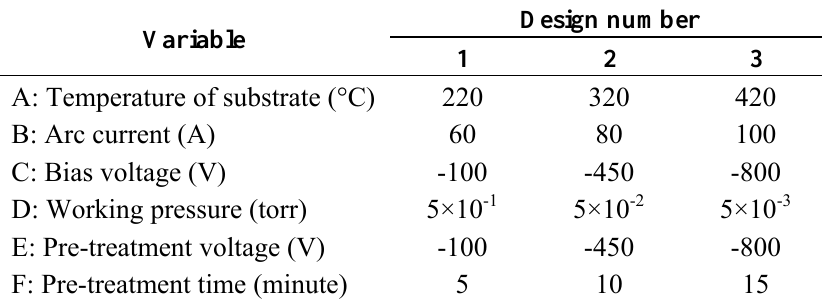
Table 1. Taguchi L18 experimental design: Variables.